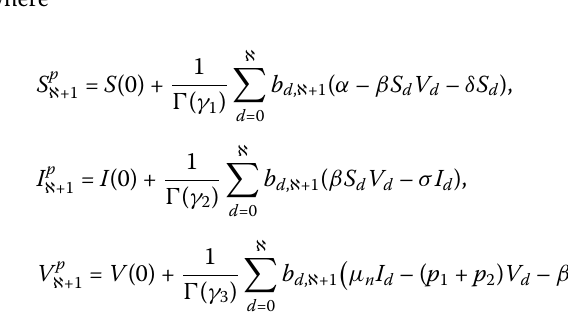
Values of endemic equilibrium in 60 days γ i = 1 , i = 1,2,3 γ i = 0.95 , i = 1,2,3 γ i = 0.90 , i = 1,2,3 Susceptible Adams. 0.5313 0.5217 0.516 0.5142 Infected Adams. 1.743 FreeVirus